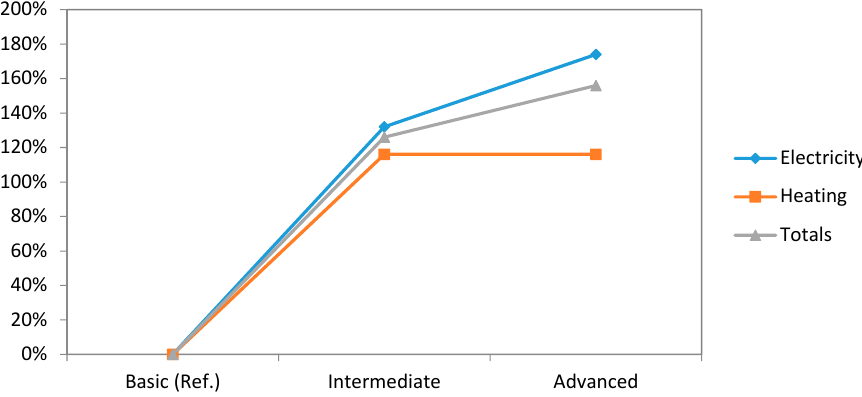
Figure 9. Comparative study graph concerning to CO 2 emissions (electricity and heating).